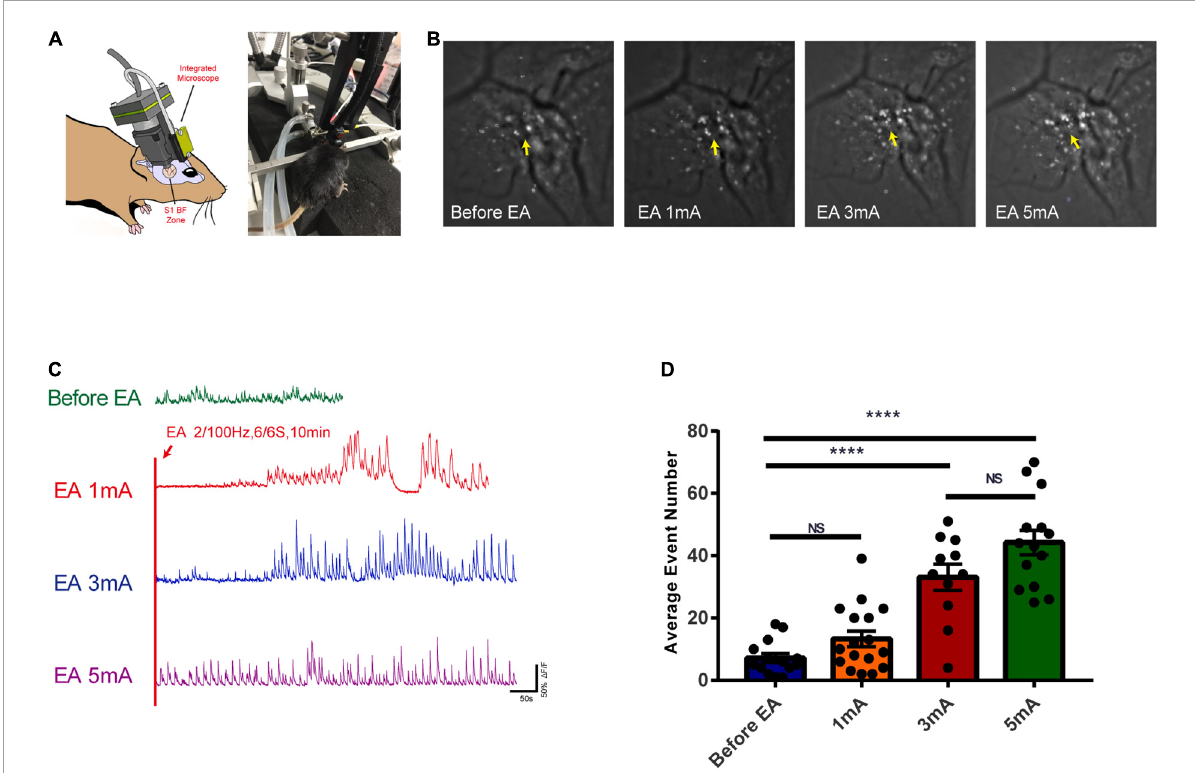
FIGURE7 Effects of EA of the trigeminal nerve at different intensities on the excitability of glutamatergic neurons in cortex S1BF 2/3 layer. (A) In vivo calcium ion imaging pattern and experimental diagram. (B) Calcium accumulation map of glutamatergic neurons before and during EA at different intensities. (C) Traces map of glutamatergic neurons at different intensities. Traces map of glutamatergic neurons before and during EA at different intensities found that the calcium wave of glutamatergic neurons changed rhythmically with the intensity of EA. (D) The average calcium wave event number for each group found that the calcium wave event increased with the increase in EA intensity, **** P < 0.0001, before EA group vs. 3 mA and 5 mA groups; P > 0.05, before EA group vs. 1 mA group and 3 mA group vs. 5 mA group, n =